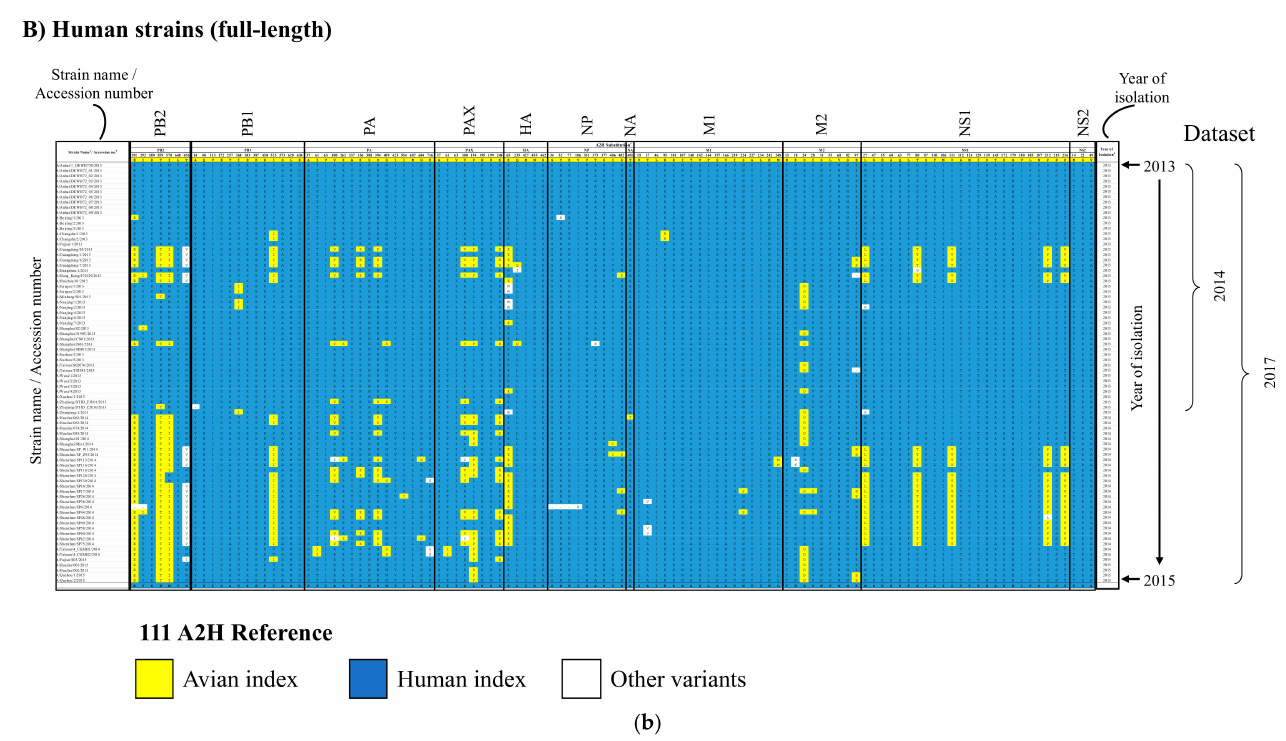
Figure 5. Heat map depicting timeline of adaptation to avian-to-human substitution (A2H) for all proteins of influenza A among publicly reported, full-length avian and human influenza A(H7N9) virus strains. Using the 109 A2H substitution sites identified from the 2014 dataset and the two new sites from 2017 dataset as a reference, corresponding signature residues for each reported avian ( A ) and human ( B ) H7N9 strain sequence are shown in alignment to the reference and arranged in chronological order of strain isolation (up to 2016 for avian strains and 2015 for human strains; only strains reported with full-length protein sequences were analyzed; full-length strains that could not be ascertained by the accession were ignored). The signature columns within each protein show the residue observed at each of the A2H substitution sites. Each strain is annotated with subtype, year and country of isolation, and isolate name. The first and the last pattern of the alignment are the avian-to-human substitution (A2H) residues, with the avian index sequence as the first (top) pattern and the human index sequence as the last pattern (bottom). Signature residues characteristic of the avian index are shown on a yellow background, while residues characteristic of the human index are shown on a dark blue background, and all other variants are on white. A higher resolution of the image, with visible details, is provided in Supplementary Table